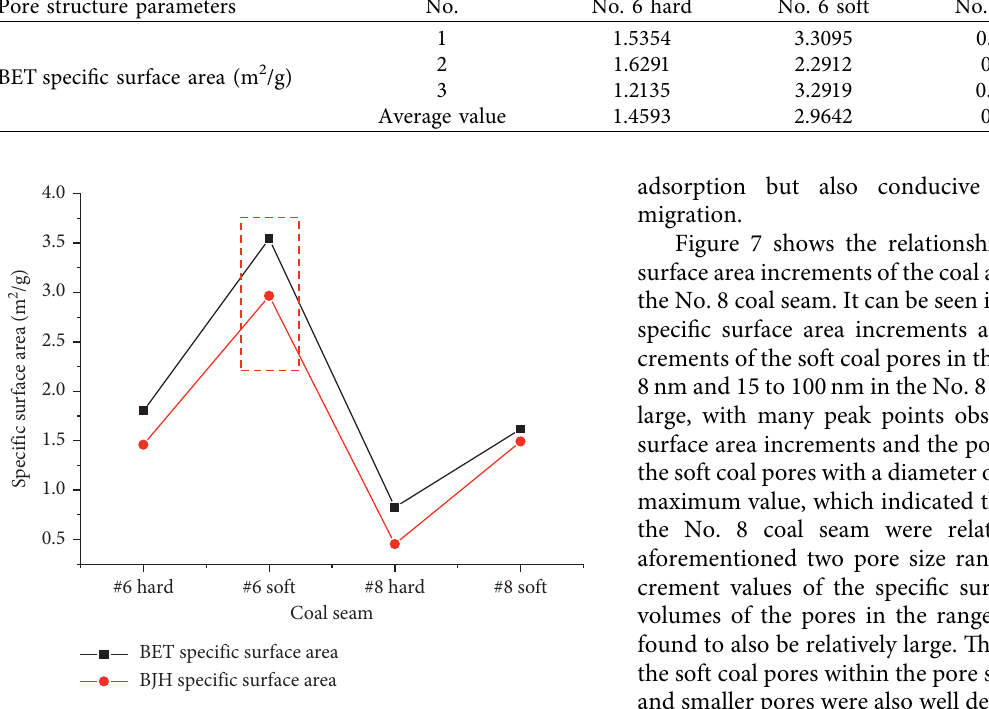
Figure 3: Distributions of the BETand BJH specific surface areas of the different coal